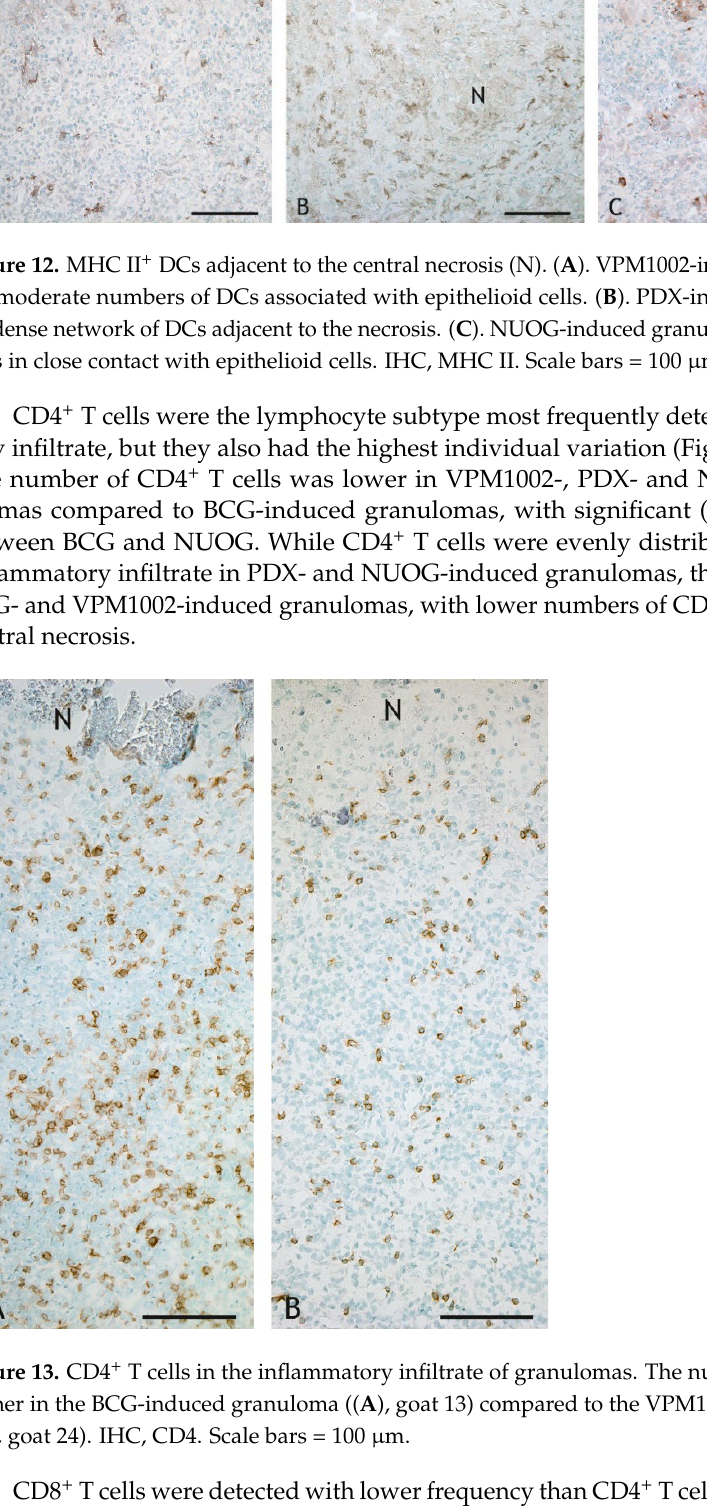
Figure 11. Composition of inflammatory cell infiltrates in BCG-, VPM1002-, PDX- and NUOG-in- duced granulomas. Each column represents 6 goats, with 15 reference areas counted per goat. Inter- quartile range (IQR, grey box), median (line) as well as maximum and minimum (whiskers) are indicated. x outliers, more than 1.5 IQR below first quartile or above third quartile, * significant differences ( p < 0.05) from BCG-induced granulomas.